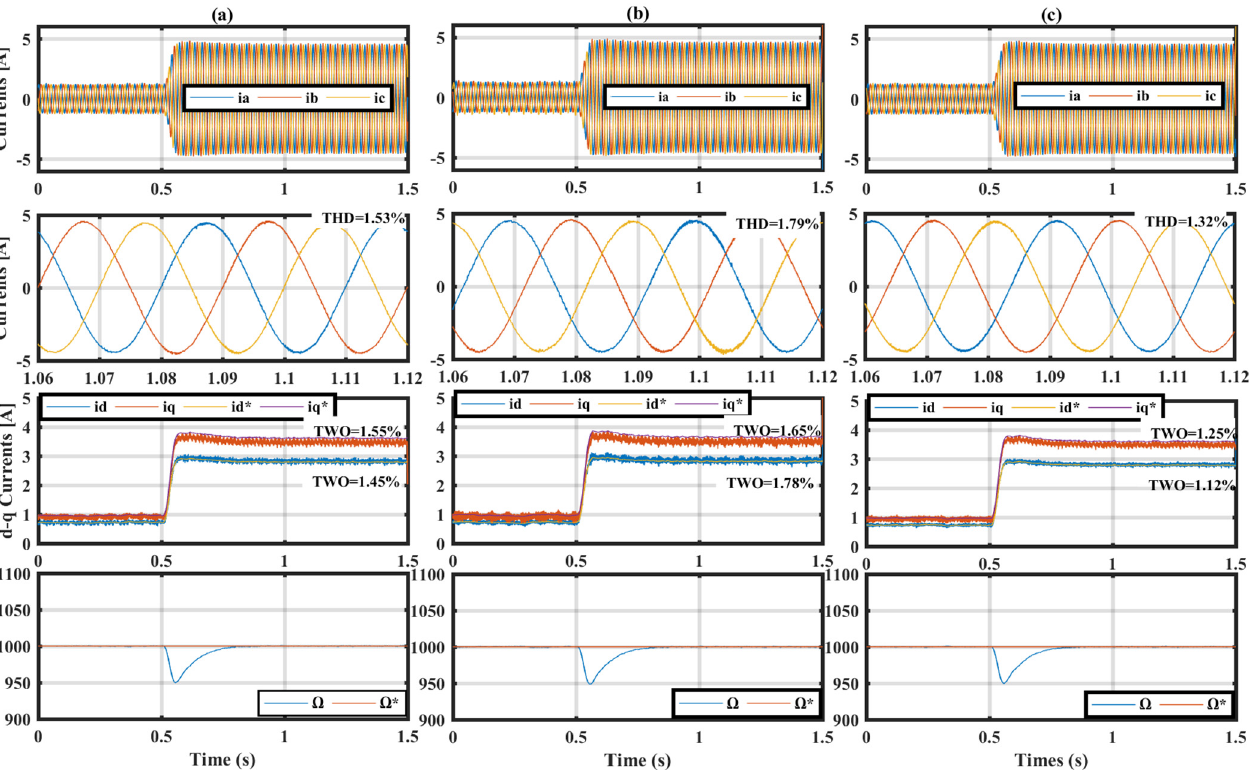
Figure 5. Experimental results: ( a ) MPCC (T s = 35 μ s), ( b ) HCC–MPCC (T s = 35 μ s) and ( c ) HCC–MPCC (T s = 28 μ s), under a step-torque load.